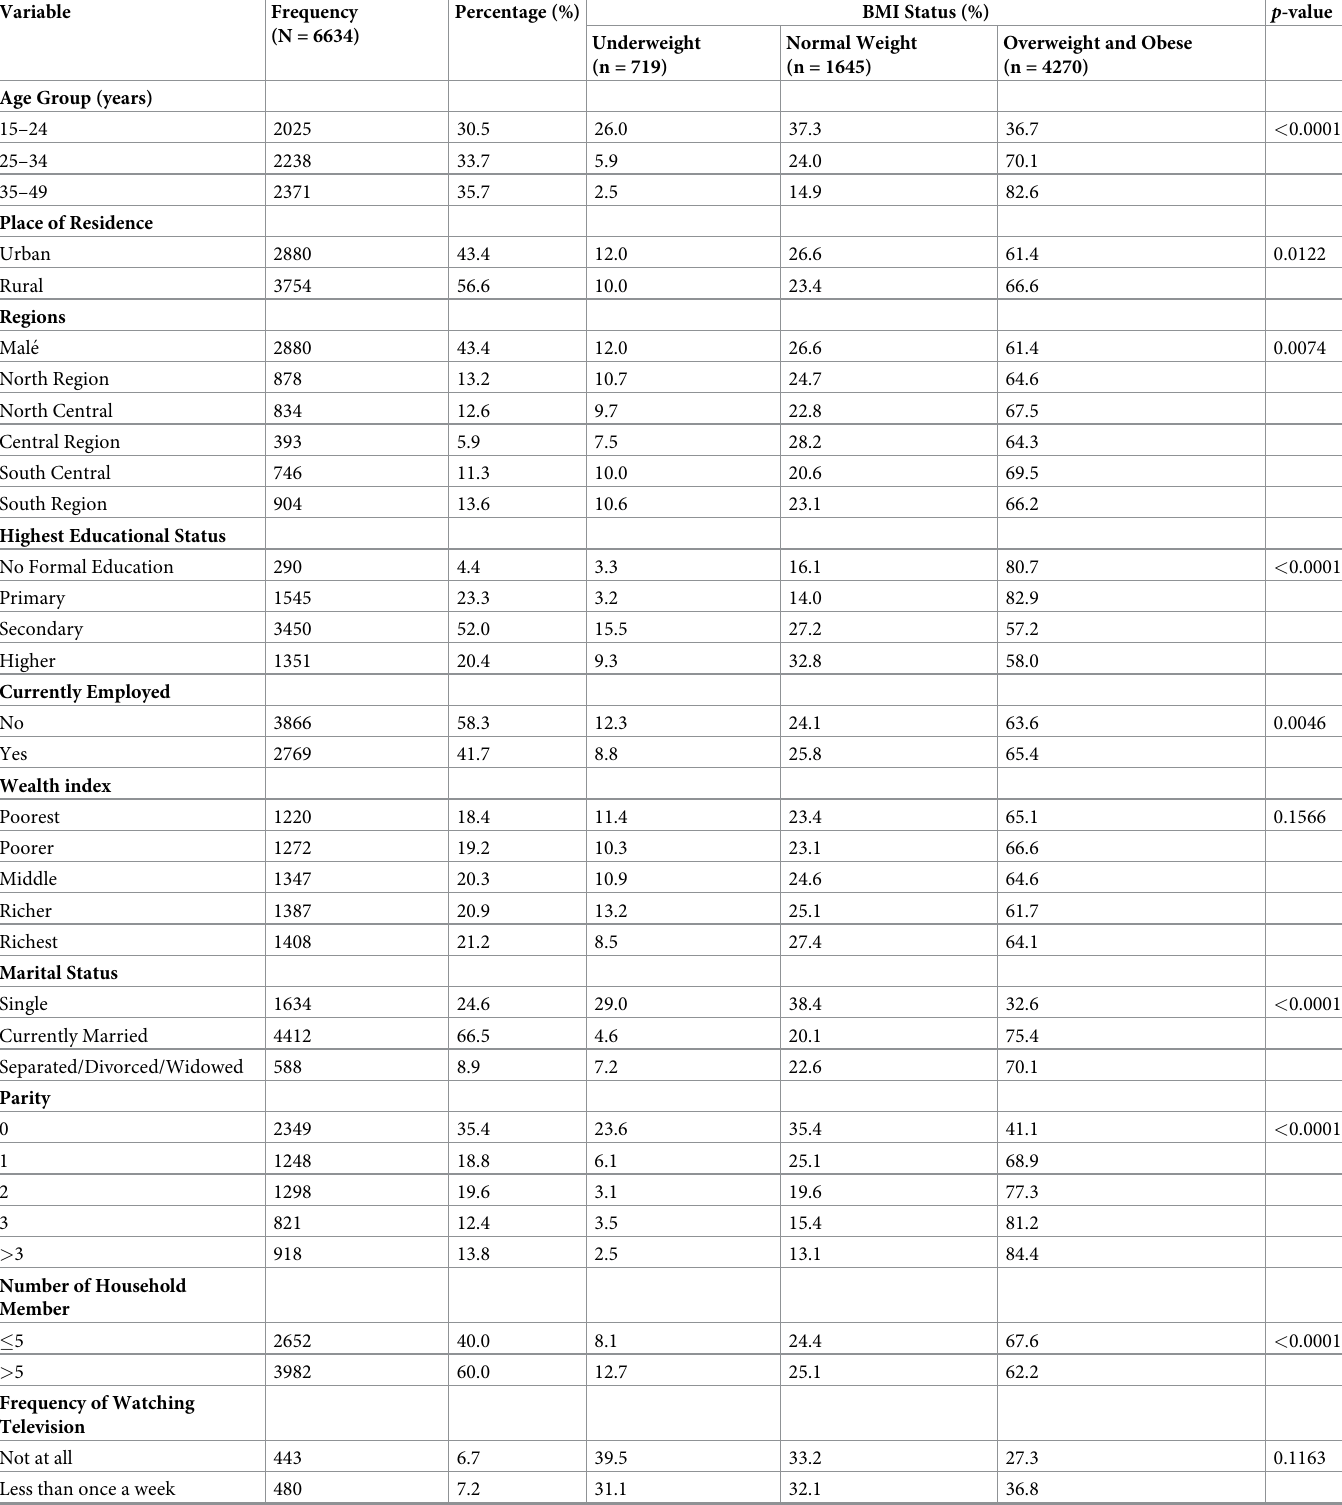
Table 1. Distribution of basic characteristics of respondents according to BMI status, n (%) � (N =